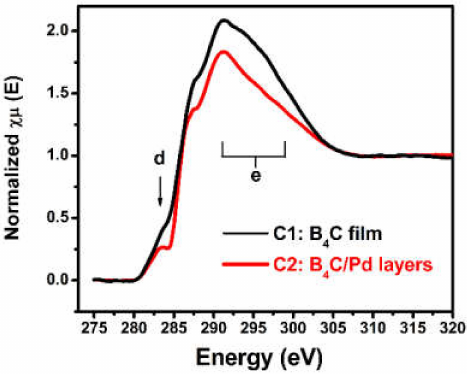
Figure 3. The C K-edge XANES spectra of the B 4 C film and B 4 C/Pd layers placed in the dry oxygen-rich